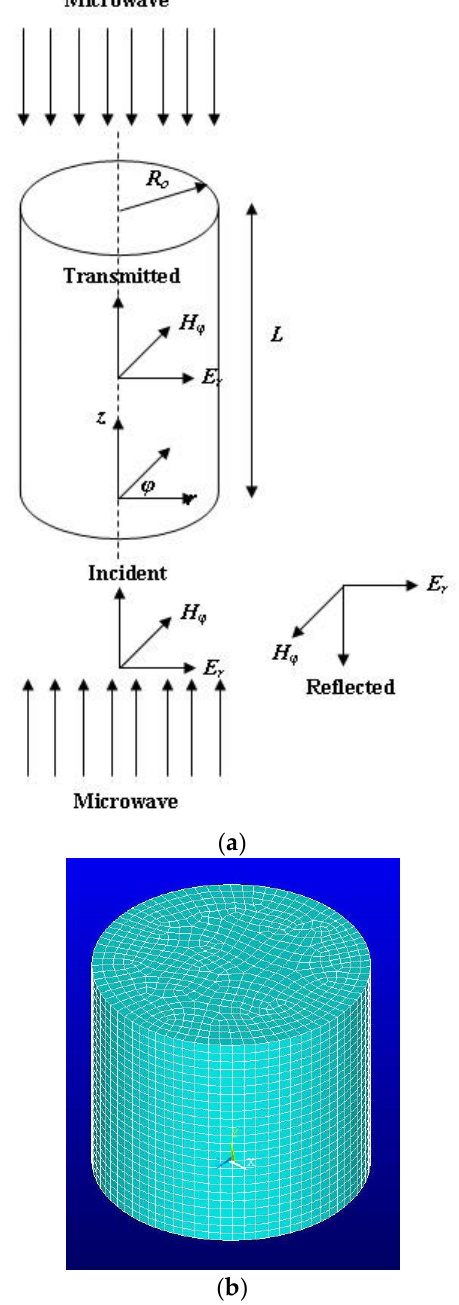
Figure 1. Schematic of microwave heating for cylinder object: ( a ) cylinder; ( b ) typical FE mesh for the cylinder object.